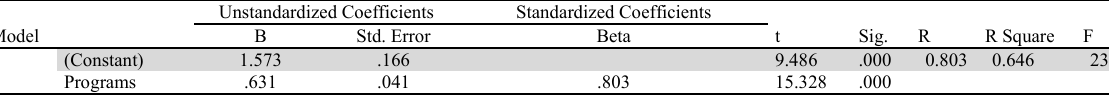
The results of testing the second sub-hypothesis